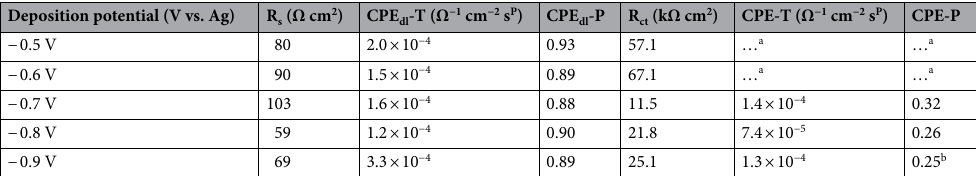
Table 2. Fitting results for impedance spectra recorded after 18 h immersion in 0.05 mol dm −3 NaCl solution of Ni–Mo coatings calculated using both electric equivalent circuits presented in Fig. 13. a For coatings deposited at − 0.5 V and − 0.6 V Model 1 from Fig. 13 was used for the fitting procedure, while for these deposited at − 0.7 V, − 0.8 V and − 0.9 V—‘Model 2’ was adopted. b The parameter P of CPE was fixed to 0.25.